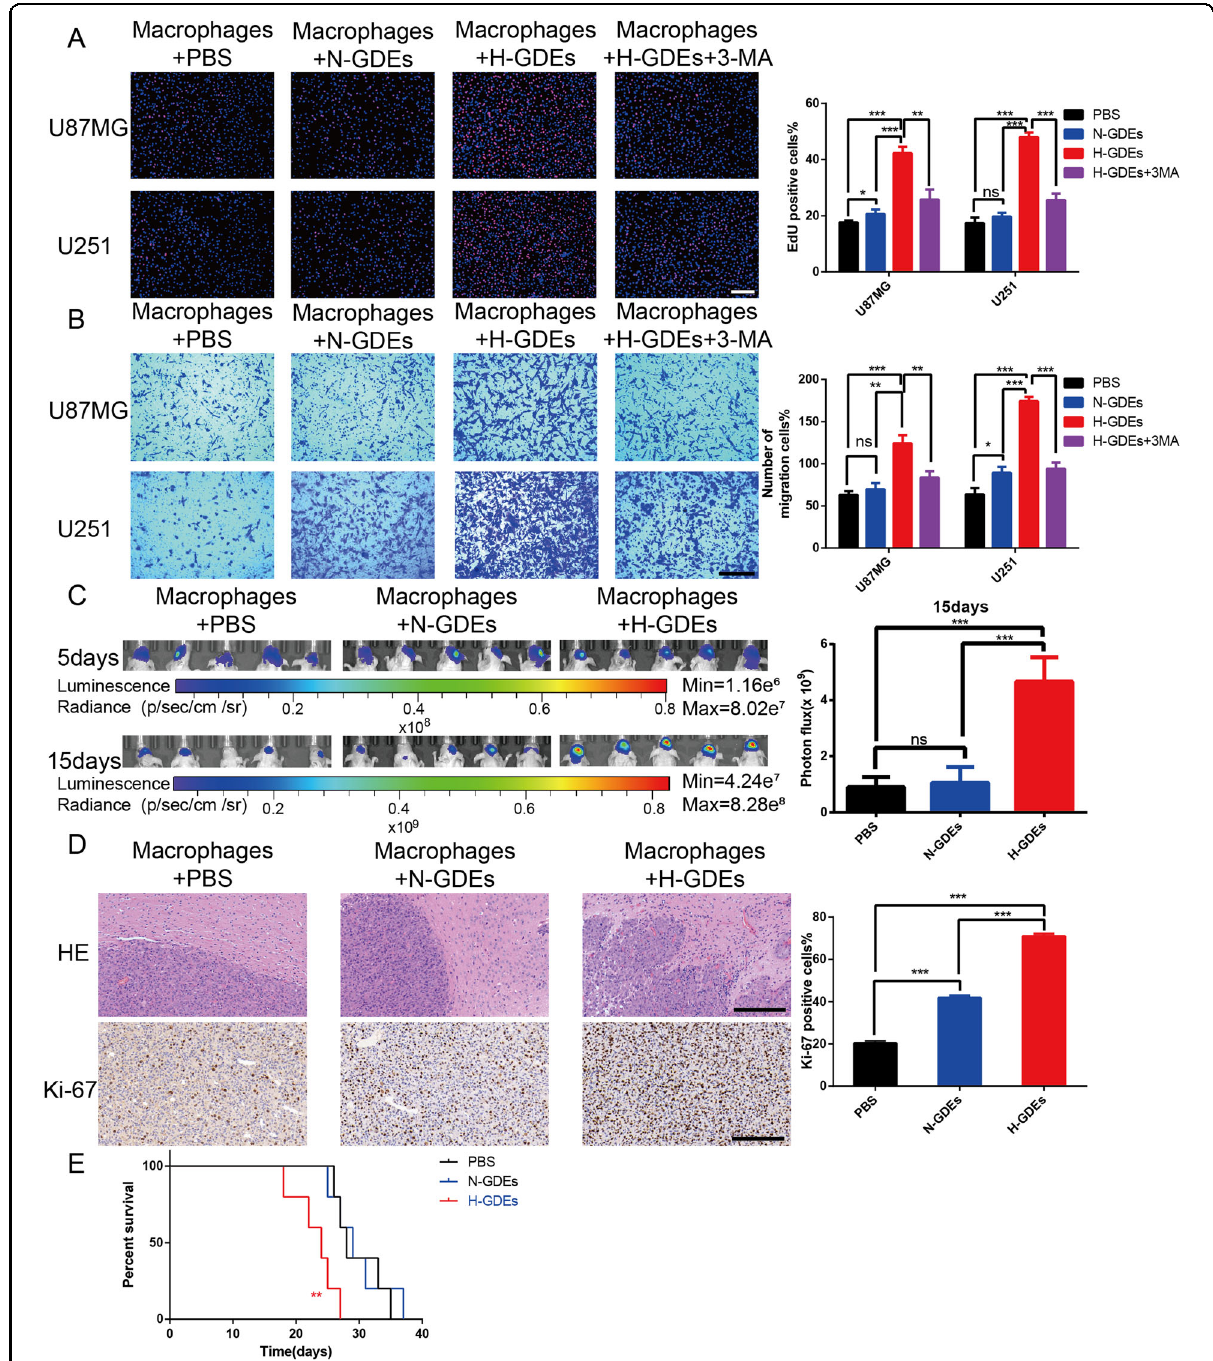
Fig. 3 Macrophages treated with H-GDEs promote glioma progression in vitro and vivo. A Human monocyte U937 cells were incubated with PMA (100ng/ml) for 24 h in vitro to induce them to differentiate into macrophages. An EdU assay evaluated the proliferation of U87MG or U251 cells cocultured with macrophages treated with PBS, N-GDEs, H-GDEs, or H-GDEs + 3-MA, and the results were quanti fi ed (scale bar, 100 μ m). B The migration capacity of U87MG or U251 cells cocultured with conditioned macrophages was determined. Representative images of migratory cells and quanti fi cations are shown (scale bar, 200 μ m). C In vivo bioluminescent imaging analysis of tumor growth in xenograft nude mice bearing U87MG cells with PBS-macrophages, N-GDEs-macrophages, or H-GDEs-macrophages. Representative images on day 5 and 15 post-implantation are shown (data are from fi ve mice per group). D HE staining and IHC staining for Ki-67 of sections from xenograft mouse brains with U87MG and PBS- macrophages, U87MG and N-GDE-macrophages or U87MG and H-GDE-macrophages on the day of euthanasia (scale bar, 200 μ m). E Survival analysis of animals implanted with U87MG and PBS-macrophages, U87MG and N-GDEs-macrophages or U87MG and H-GDEs-macrophages ( P < 0.01 by log- rank analysis; data from fi ve animals per group). (* P < 0.05; ** P < 0.01; *** P < 0.001). Of fi cial journal of the Cell Death Differentiation